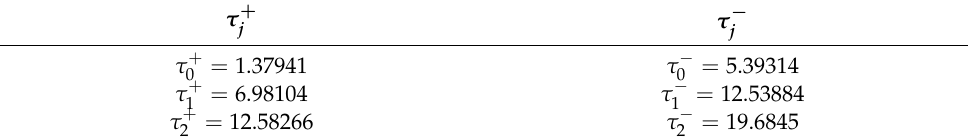
Table 3. τ values.